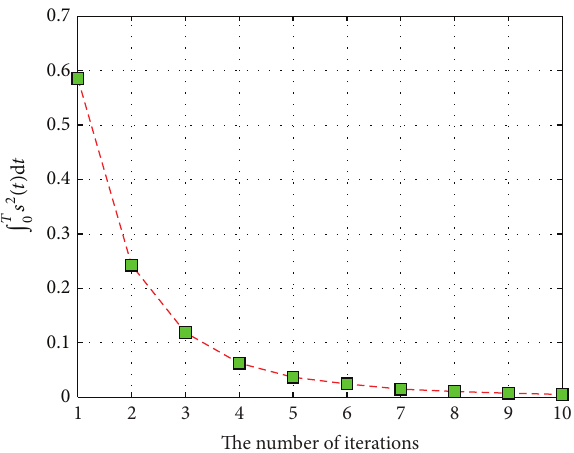
𝑇 𝑠 2 (𝑡) d 𝑡 versus the number of iterations in Case Figure 11: ∫ 𝑘 0